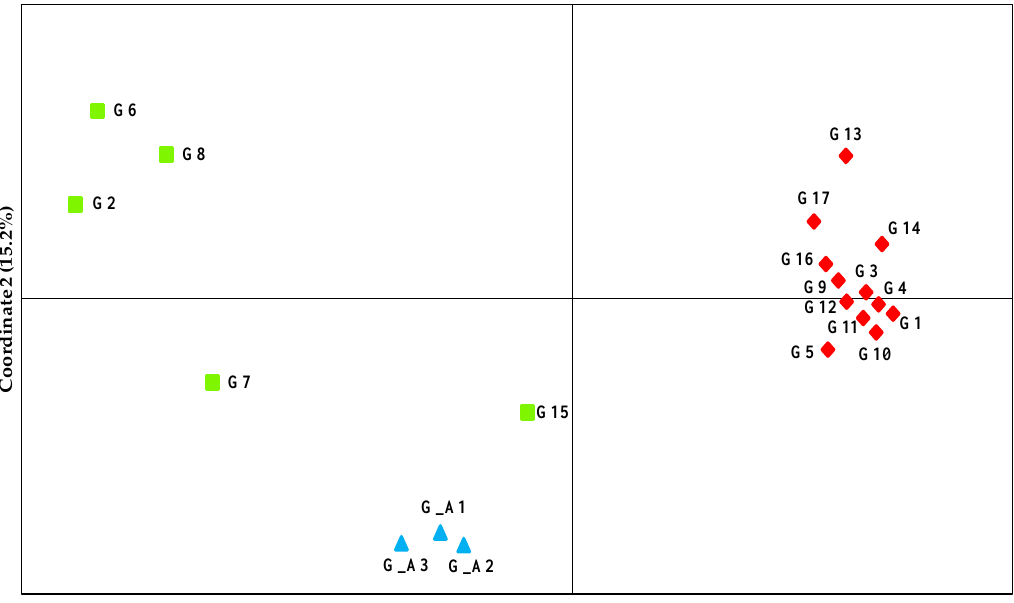
Figure 3. Principal coordinates analysis (PCoA) of the 17 genotypes (G1 to G17) found in the 139 black amaranth accessions, and the three genotypes found in the commercial variety INAP-Alegría (G_A1, G_A2, and G_A3). Percentages of variation explained by each of the first two coordinates are indicated. Color of each genotype matches that assigned in the STRUCTURE analysis: Cluster 1 in red and Cluster 2 in green. Genotypes of commercial variety INIAP-Alegría are in blue.